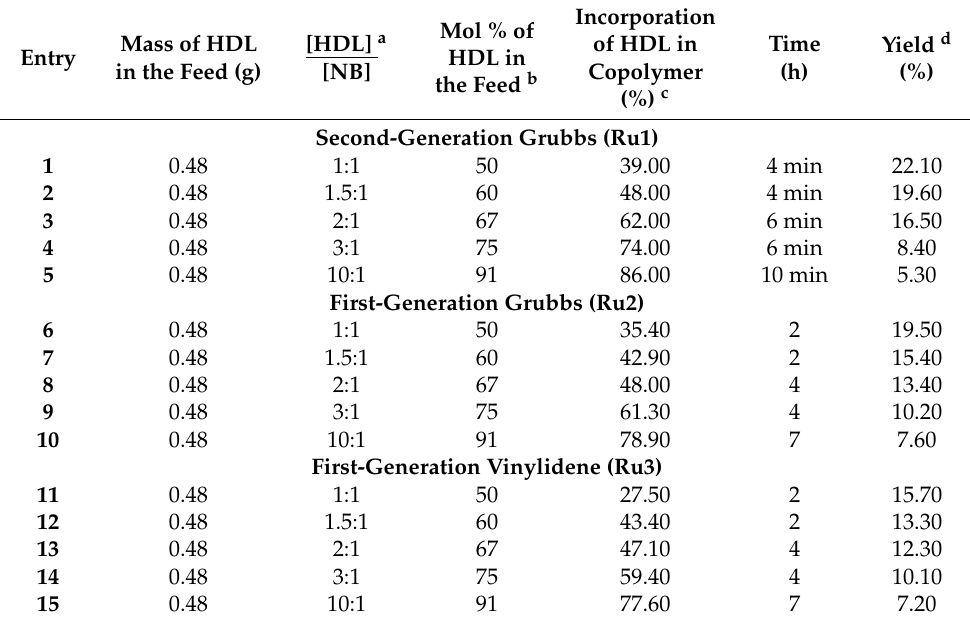
Table 2. Copolymerization conditions of HDL and NB monomers for reactivity constants determination.